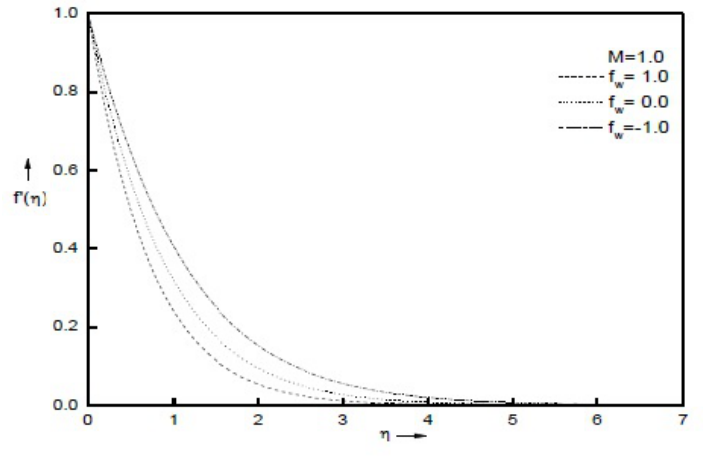
Fig. 2 Velocity profiles f (cid:48) ( η ) for various values of porosity parameters f w for M = 1 .